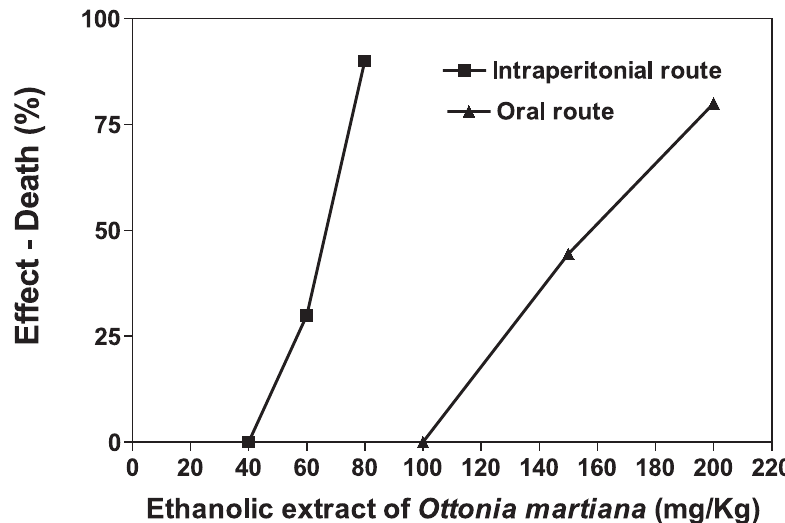
Figure 1 - Acute toxicity of ethanolic extract of Ottonia martiana by oral and intraperitoneal (i.p) administration. LD 148-183 mg/kg